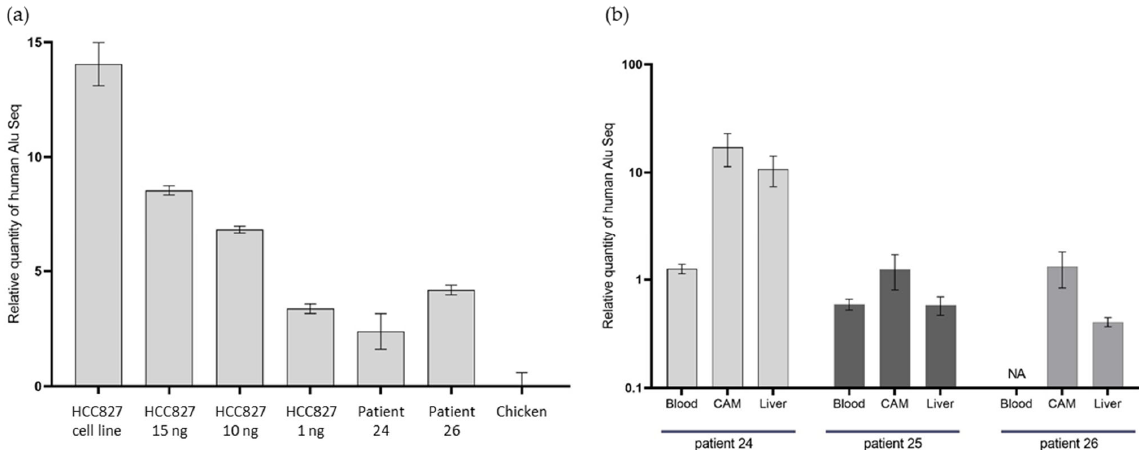
Figure 6. qPCR of DNA Alu sequences in in ovo tumors. ( a ) qPCR on DNA Alu sequences in tumors from Patients 24 and 26, with a DNA concentration range from HCC827-derived xenografts, using the cell line as a positive control and chicken tissue as a negative control. ( b ) qPCR on DNA Alu sequences in chicken embryo distant organs, following CTC engraftment from Patients 24, 25, and 26. NA: unavailable.